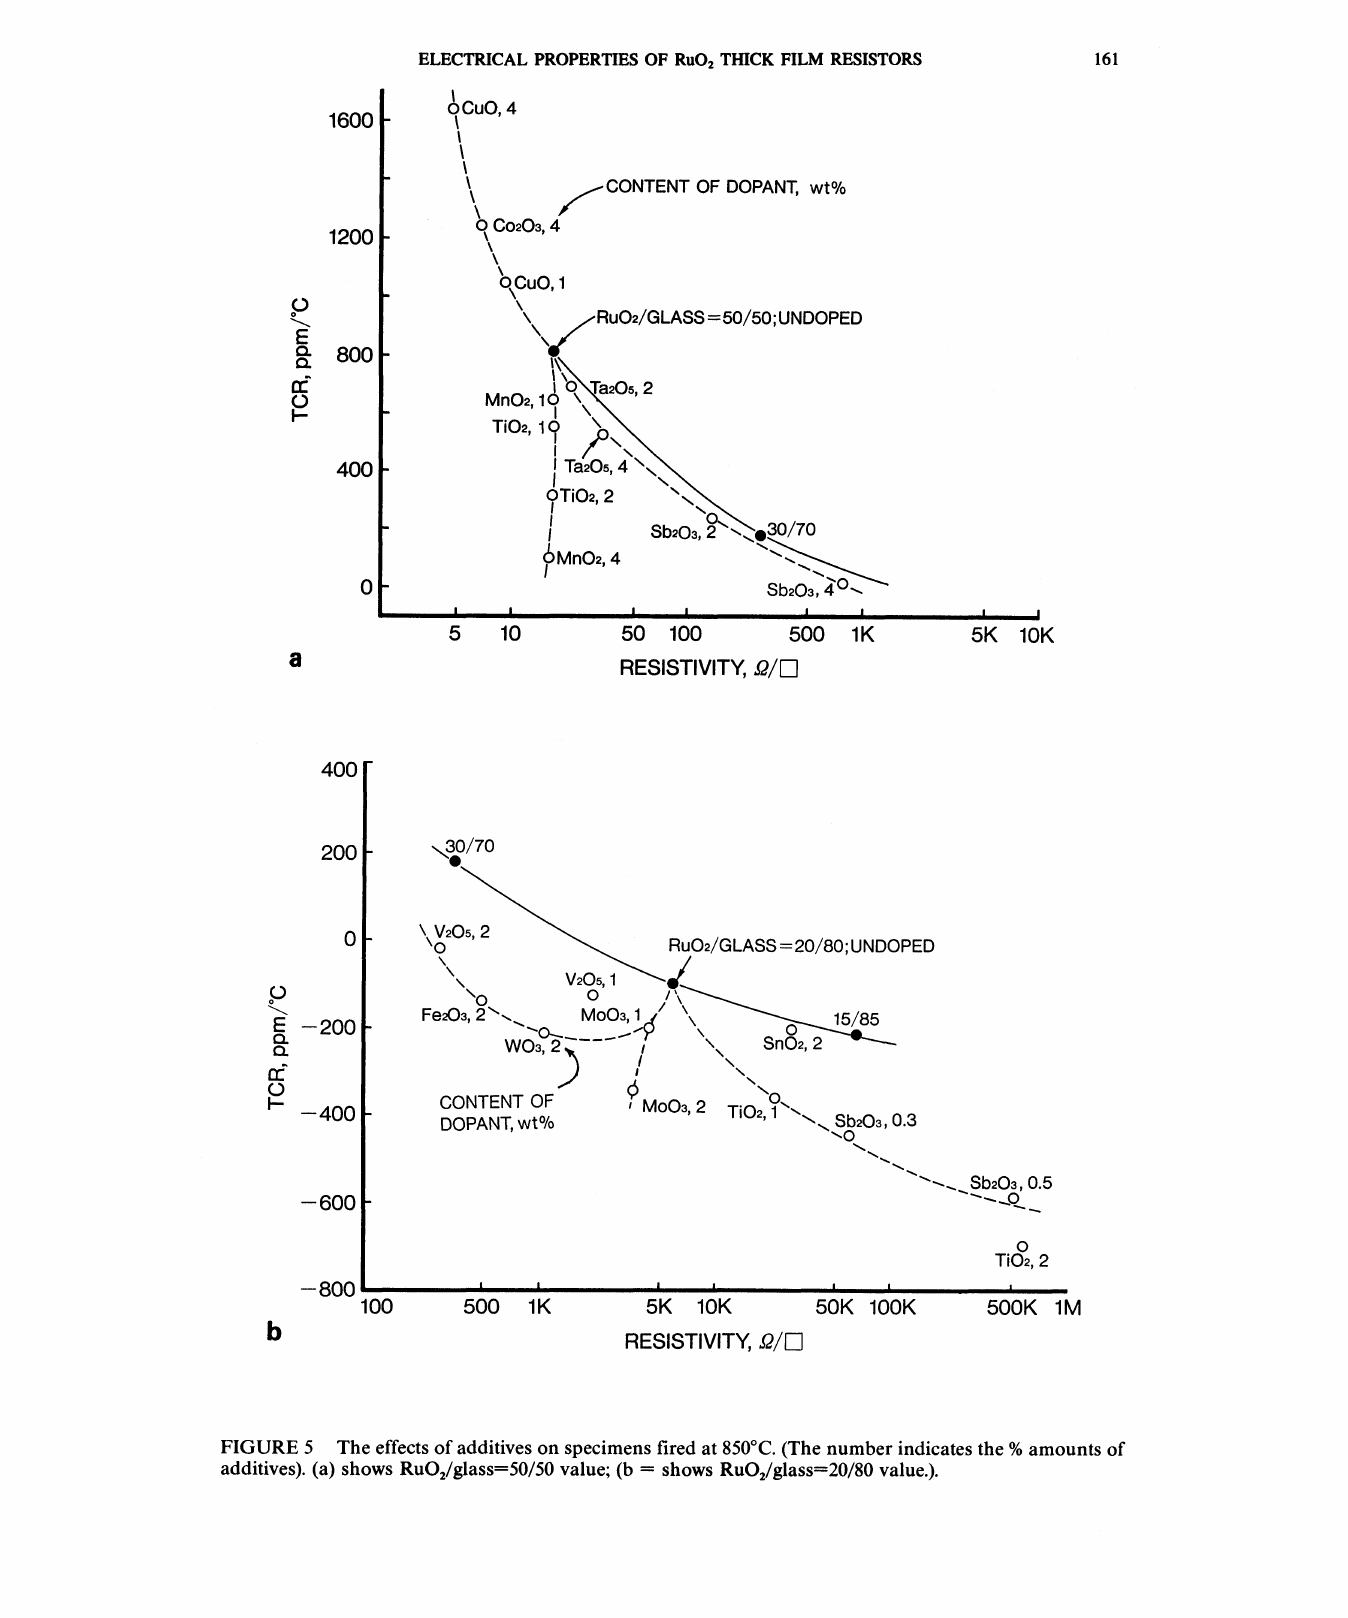
FIGURE 5 The effects of additives on specimens fired at 850C. (The number indicates the % amounts of additives). (a) shows RuO2/glass=50/50 value; (b shows RuO2/glass=20/80